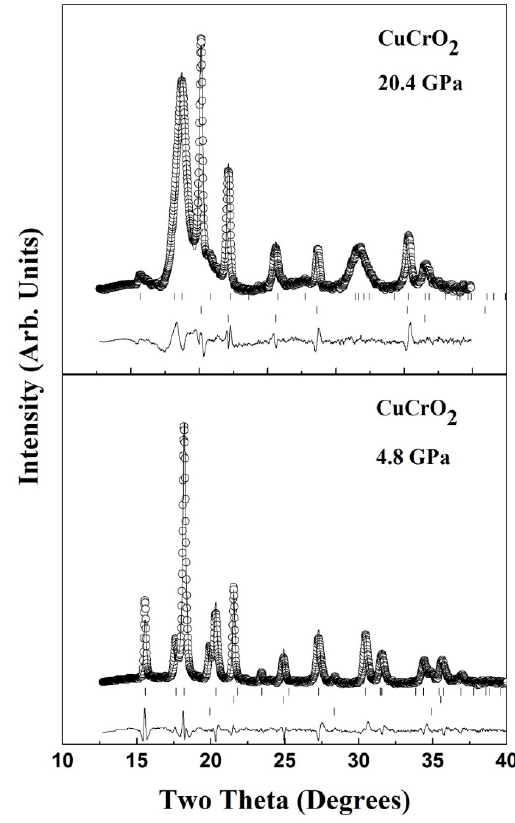
Figure 8. Observed, calculated and difference plot of X-ray powder patterns for CuCrO 2 at 4.8 GPa, at 20.4 GPa. Top, middle and bottom vertical marks indicate Bragg reflections from the sample, pressure calibrant (Cu) and sample chamber (W) respectively. The difference between fitted and observed data is also plotted.